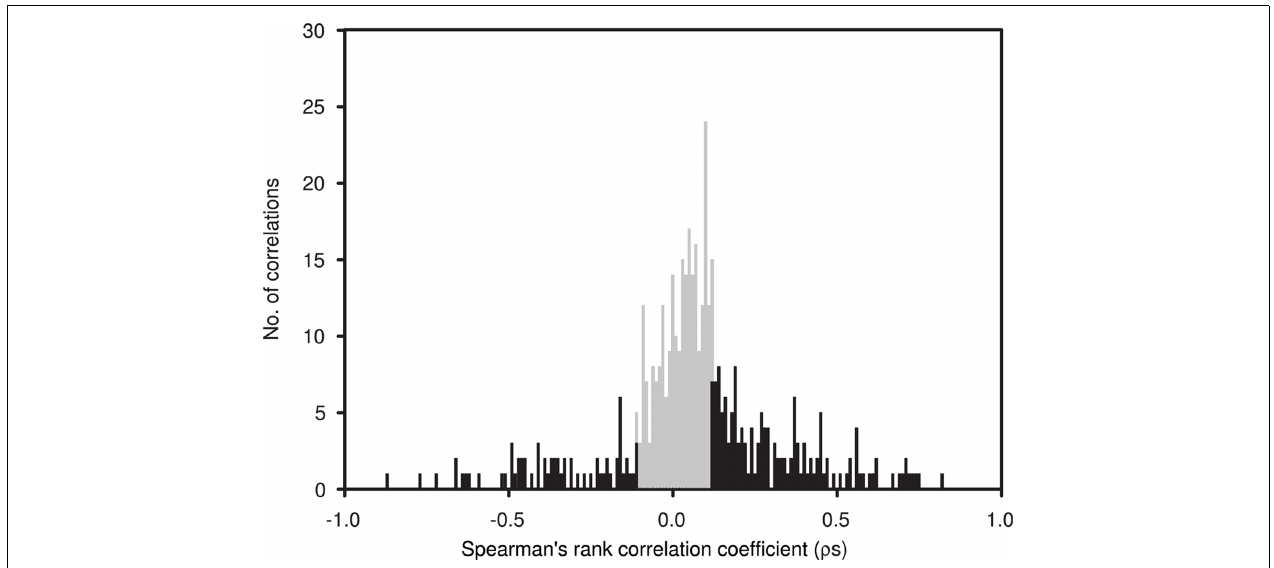
FIGURE 4 | Spearman’s rank correlation coefficients ( ρ s) between depth and the relative abundance of individual OTUs, determined byT-RFLP (number of OTUs = 397), plotted in a frequency histogram using 0.01 intervals. Significant correlations ( p < 0.05) are indicated in black. ρ sValues indicate the strength of the relationship, with positive values indicating an increase in the relative contribution of an OTU with depth and negative values indicating a decrease.